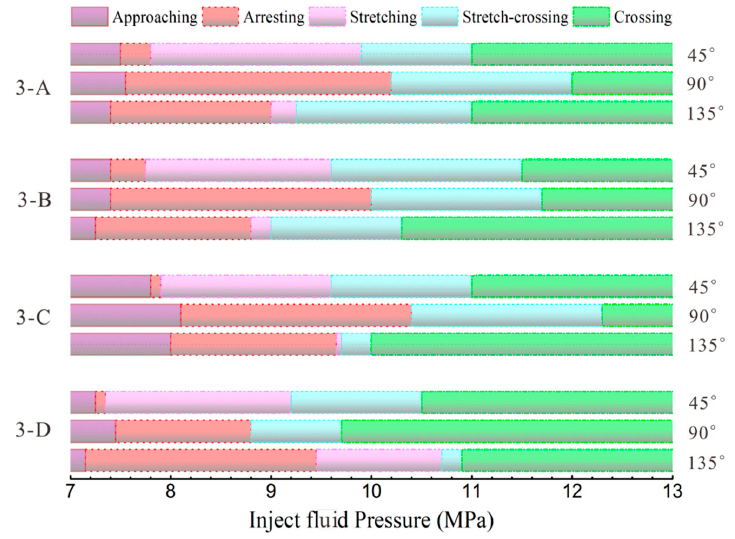
Figure 13. Fluid pressure zones for different interaction modes.